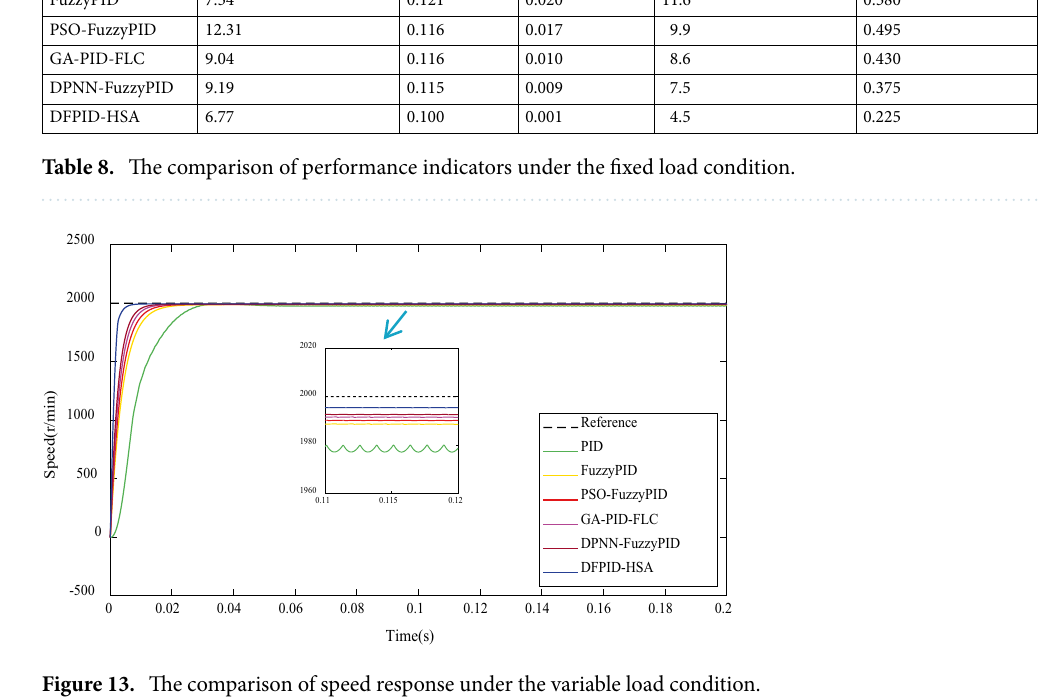
Figure 13. The comparison of speed response under the variable load condition.